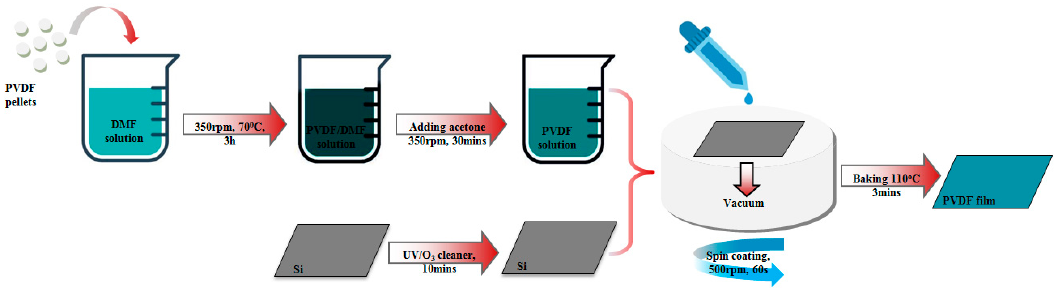
Figure 1. Scheme of the PVDF thin film elaboration steps.